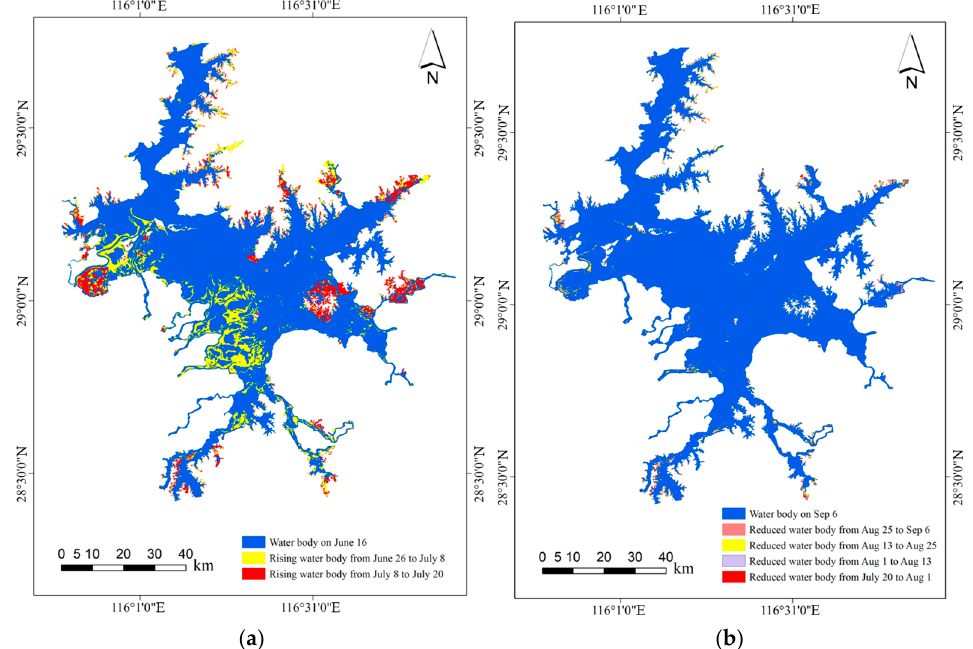
Figure 16. The spatial distribution maps of the water body in Poyang Lake. ( a ) The rising water stage, ( b ) the reduced water stage.